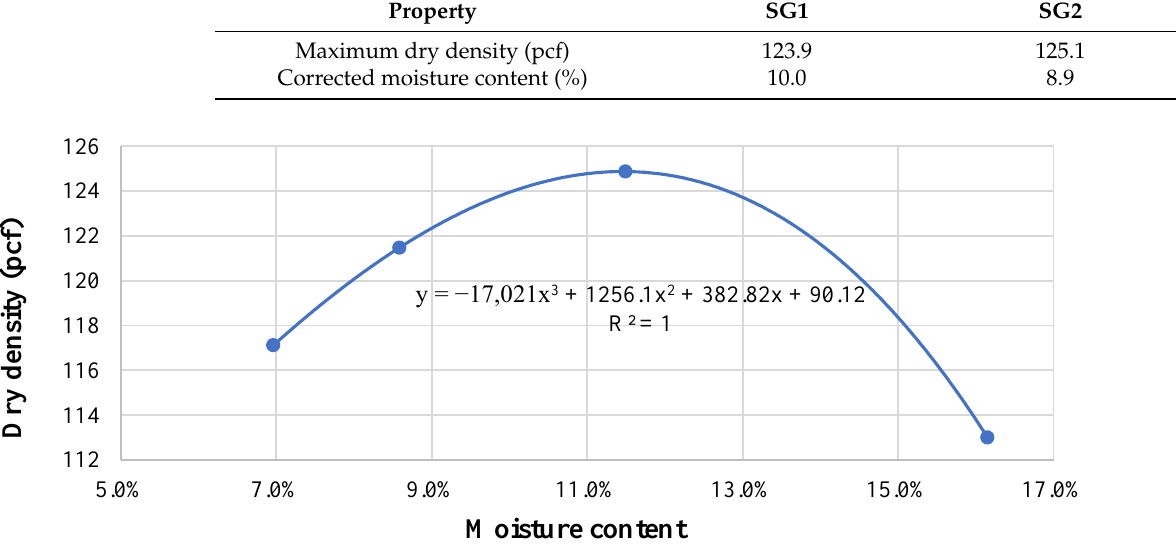
Figure 5. Moisture density curve for SG1 material.